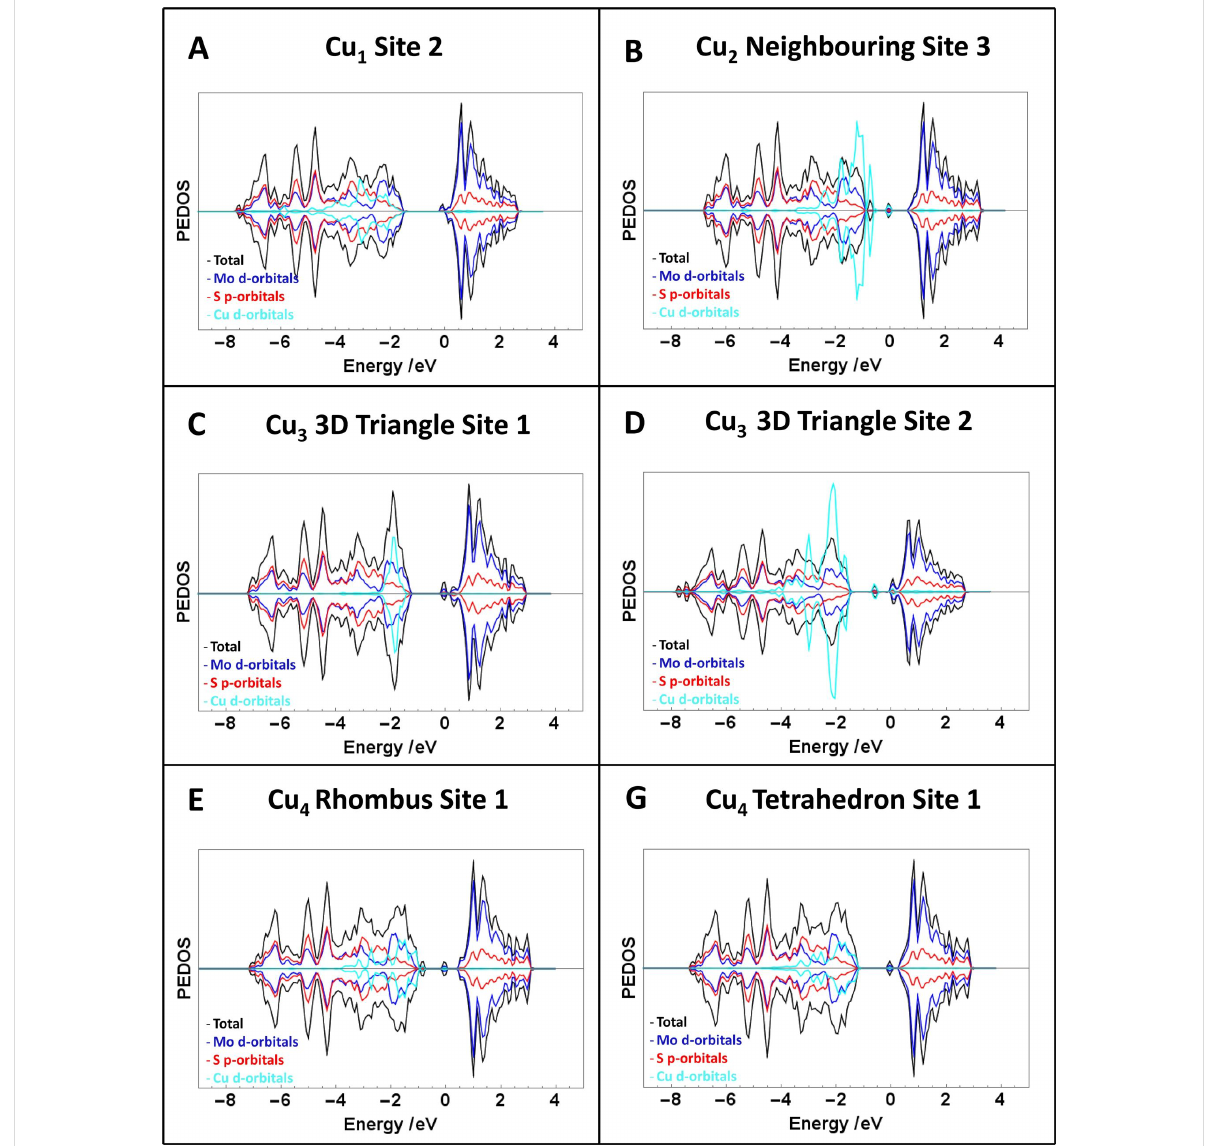
Figure 5: DOS plots of most favourable adsorption configuration for each Cu n structure on MoS 2 . The contribution of the Cu d orbitals has been in- creased by a factor of five for the ease of comparison and zero on the “energy” scale is the Fermi level.